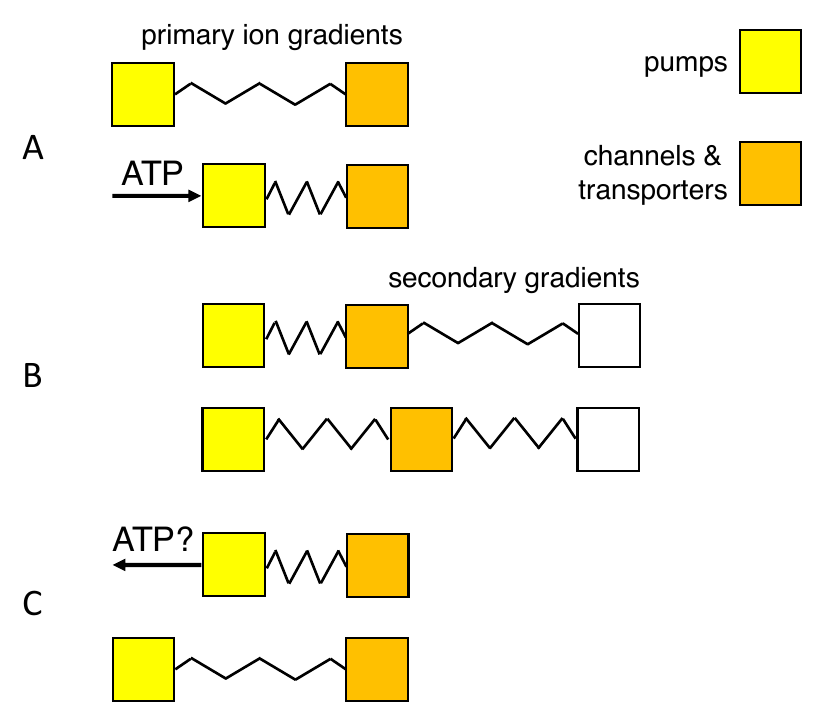
Figure 5. Mechanical equivalent of work of mixing. Boxes represent families of membrane proteins (yellow: the Na + /K + pump; orange, ion channels and transporters); displacement to the right indicates work done by transport. Springs reflect storage of potential energy in primary or secondary transmembrane gradients. ( A ) The chemical potential of ATP and its metabolites drives the Na + /K + pump and stores potential energy in the concentration gradients of the monovalent ions. ( B ) The primary ion gradients drive secondary transport of ions, water and metabolites. ( C ) Hypothetical ATP synthesis through backward operation of the Na + /K +